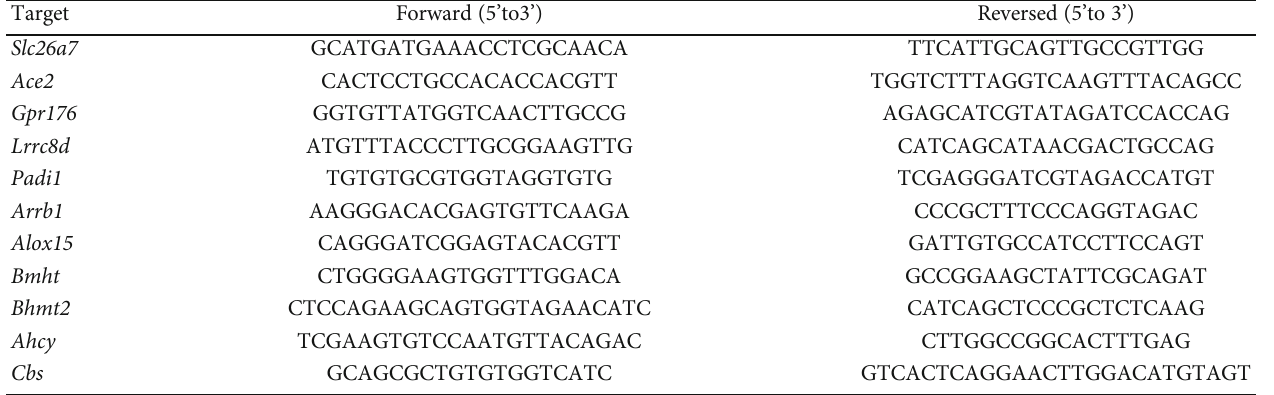
Table 1: Primer used in this